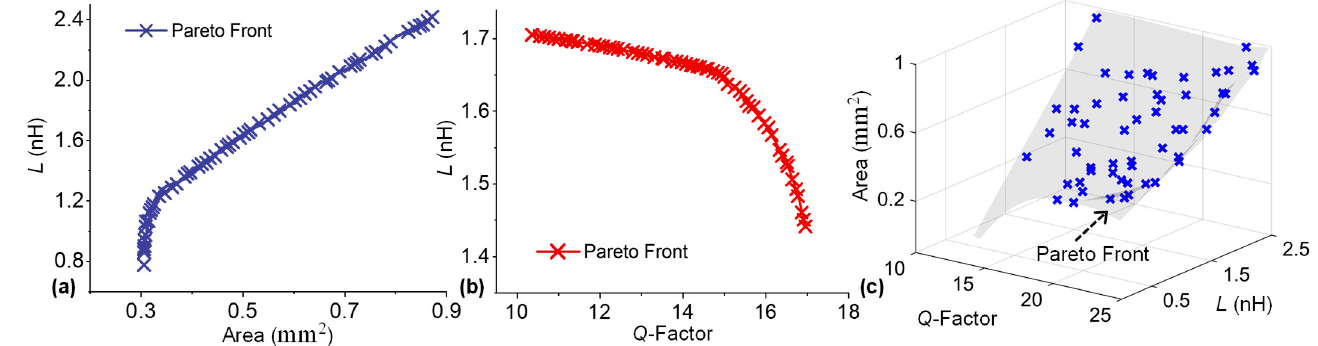
Figure 4. Non-dominated solution sets for RF-MEMS inductor optimization problem: ( a ) inductance vs. area; ( b ) Q -factor vs. inductance; and ( c ) Q -factor vs. inductance vs.